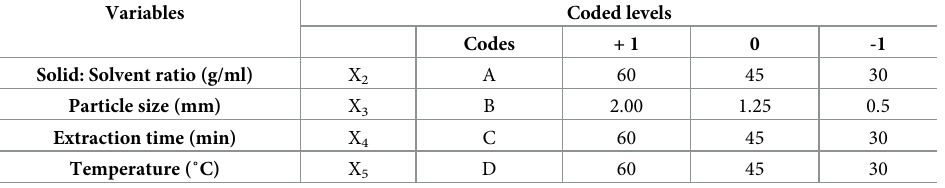
Table 5. Actual and coded treatment variables for optimization of diosgenin extraction from D . deltoidea using